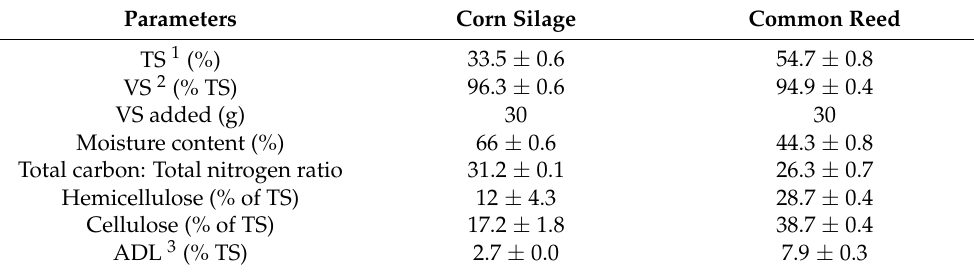
Table 1. The physicochemical characteristics of corn silage and common